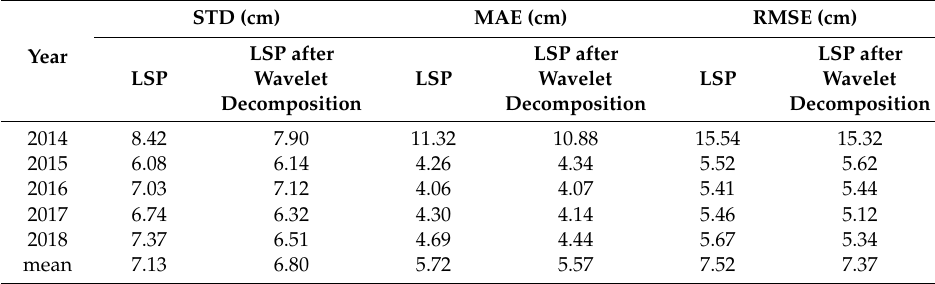
Table 1. Statistical results for the two methods for snow depth estimation over five years. STD denotes the standard deviation of snow depth estimations, while MAE and RMSE represent the di ff erences between the estimated and referenced snow